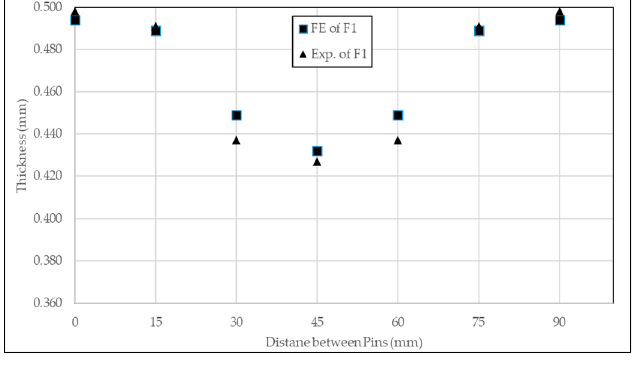
( b ) ( c ) Figure 17. Comparison of thicknesses between simulations and experiments ( a ) form1; ( b ) form2; ( c ) form3. 4. Conclusions The finite element analysis and experiments were conducted to understand the effect of pin diameter on multi-point forming. This study yielded the followings: